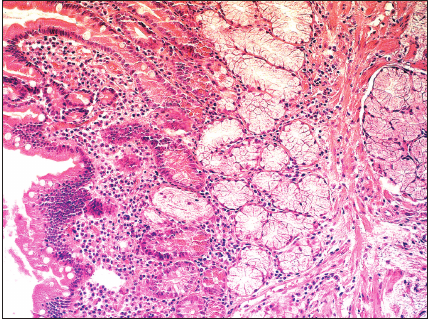
Figure 2: Antrum mucosa in H. pylori -associated gastritis: focal enteric metaplasia of epithelium, the lymphocytoplasmocytic infil- tration of lamina propria with the admixture of neutrophils, focal fibrosis, hematoxylin and eosin staining, magnitude ×